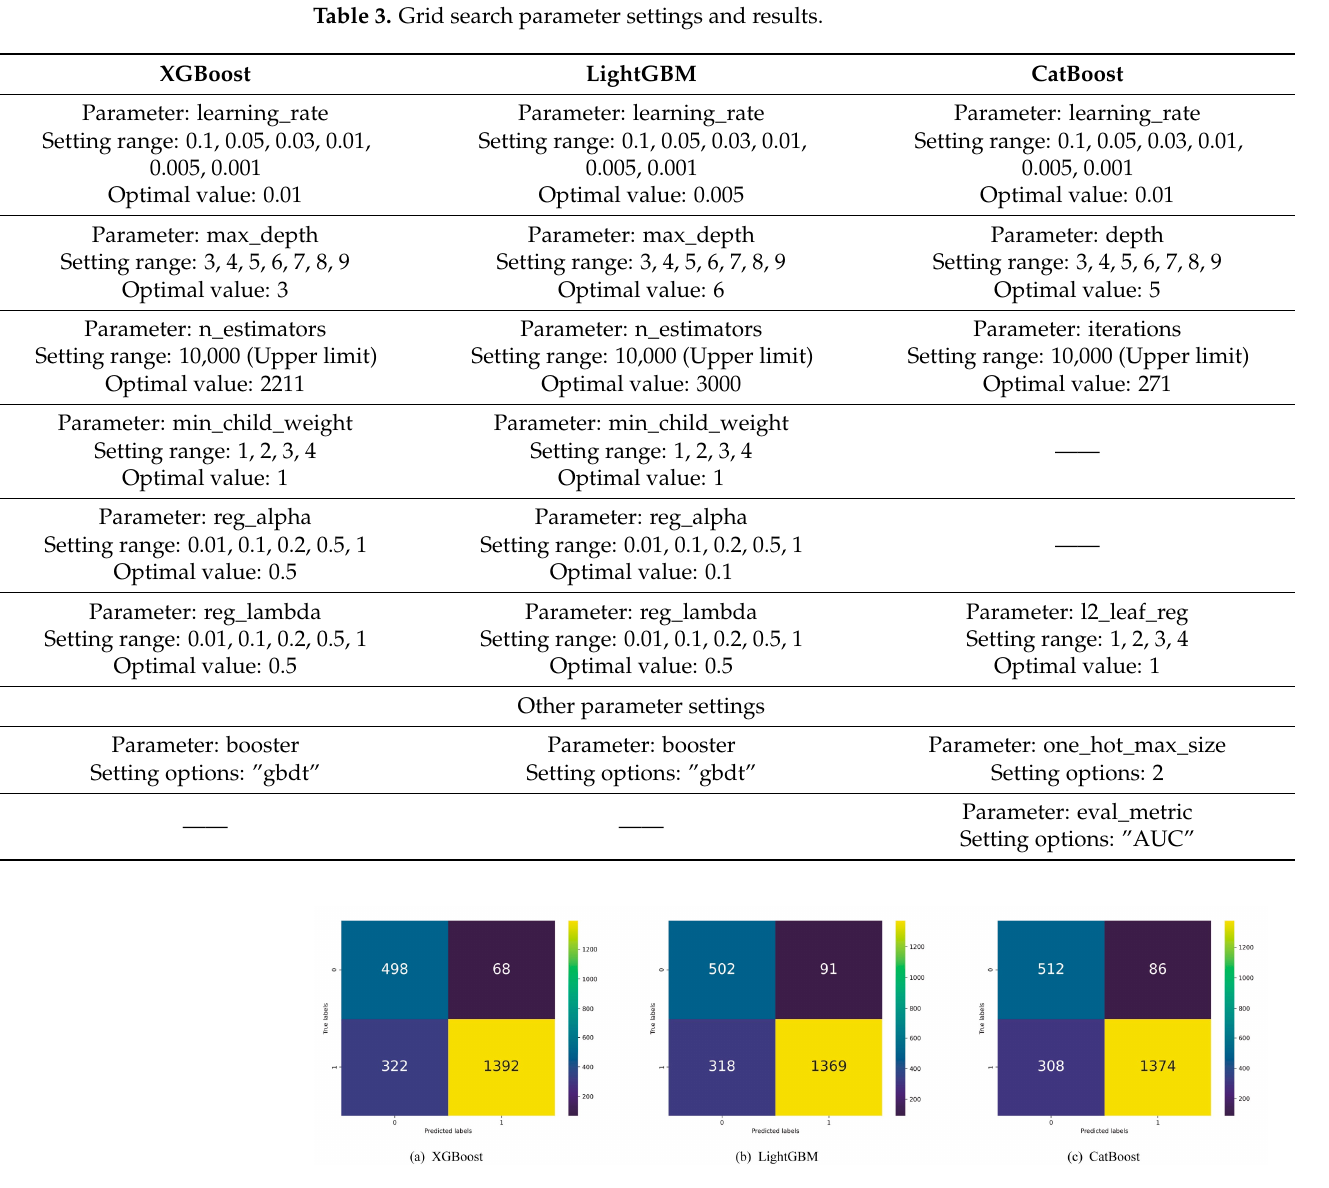
Figure 5. Confusion Matrix of XGBoost, LightGBM, and CatBoost. Table 4. Comparison of evaluation results of different